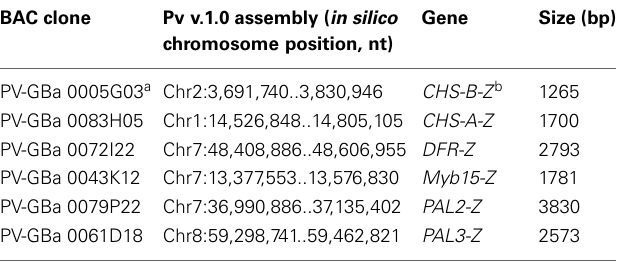
Table 3 | G19833 BAC clones containing common bean phenylpropanoid pathway